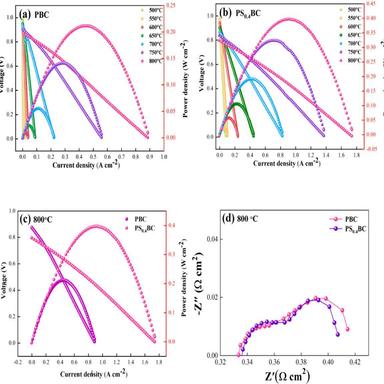
(a–b) I–V and I–P characterisation of SDC-based single cell using PBC and PS0.4BC as the cathode material at 500–800 ◦C; (c) power density comparison of the single cell with PBC and PS0.4BC cathodes operated at 800 ◦C; (d) the corresponding EIS of the single cell.